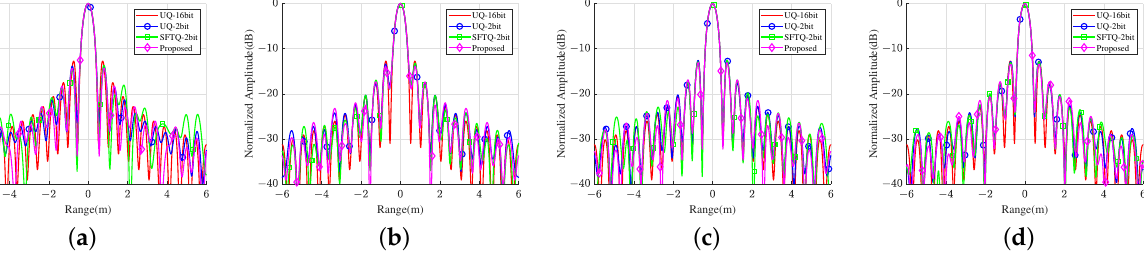
Figure 11. Range profiles of a single scatterer using different quantization schemes with different oversampling rates: ( a ) 1.1, ( b ) 1.4, ( c ) 1.7, and ( d ) 2.0.